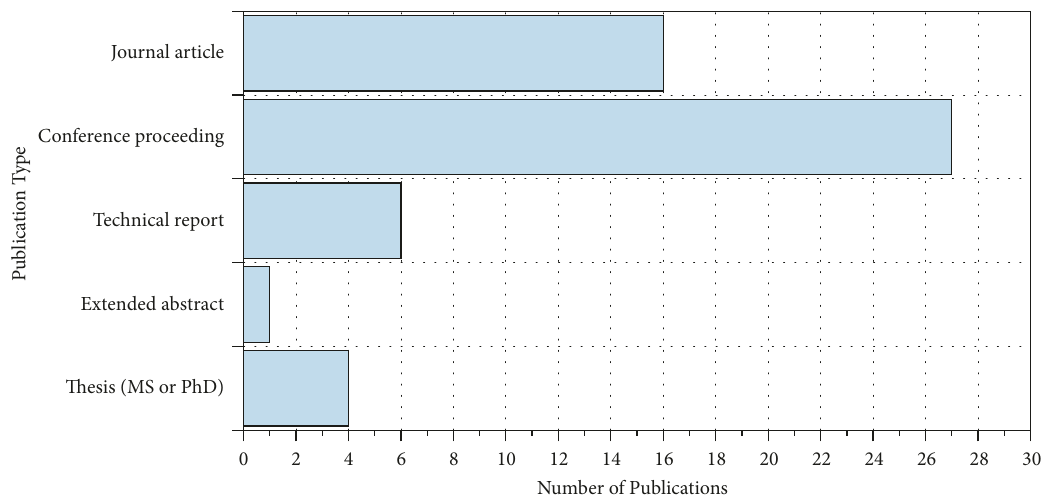
Figure 5: Distribution of primary studies across publication